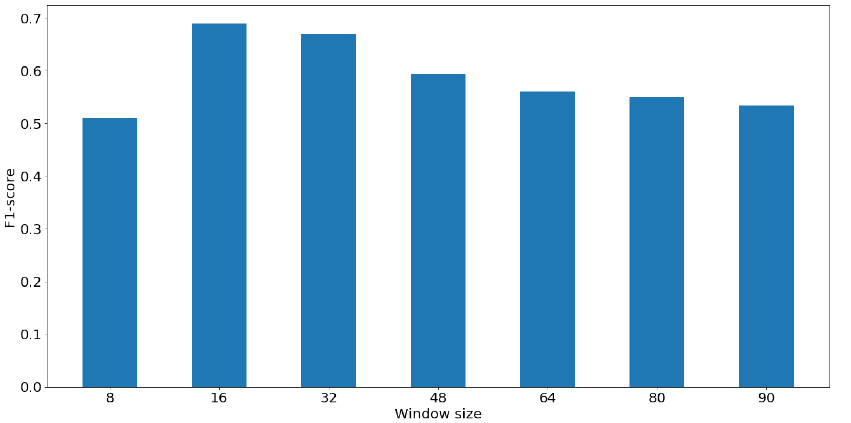
Figure 5. Classification performance evaluation for different radii to generate the GLCM